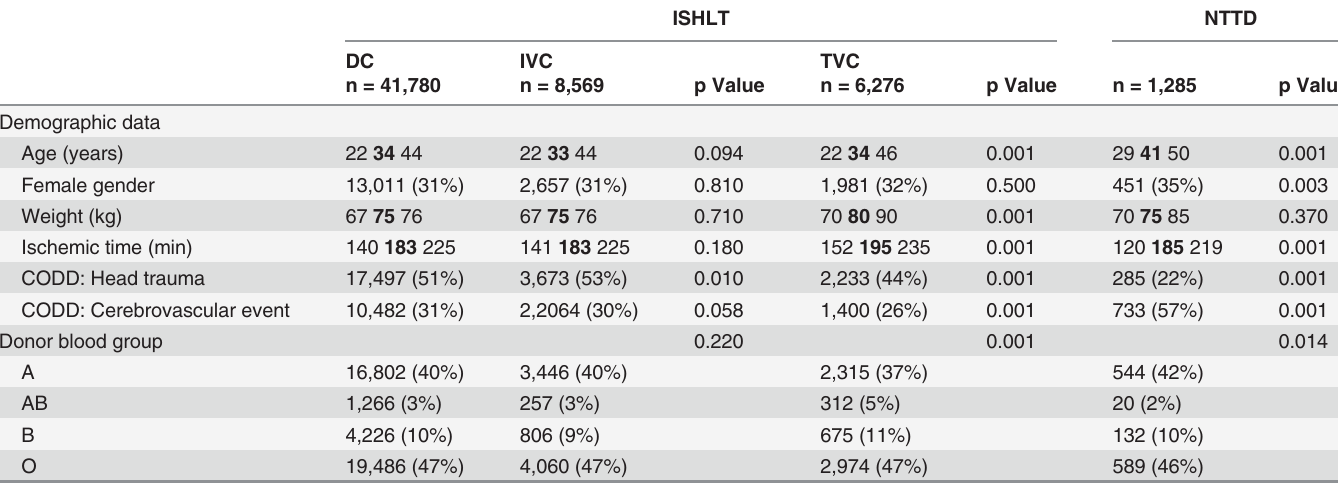
Table 2. Baseline characteristics of donors in the derivation and validation